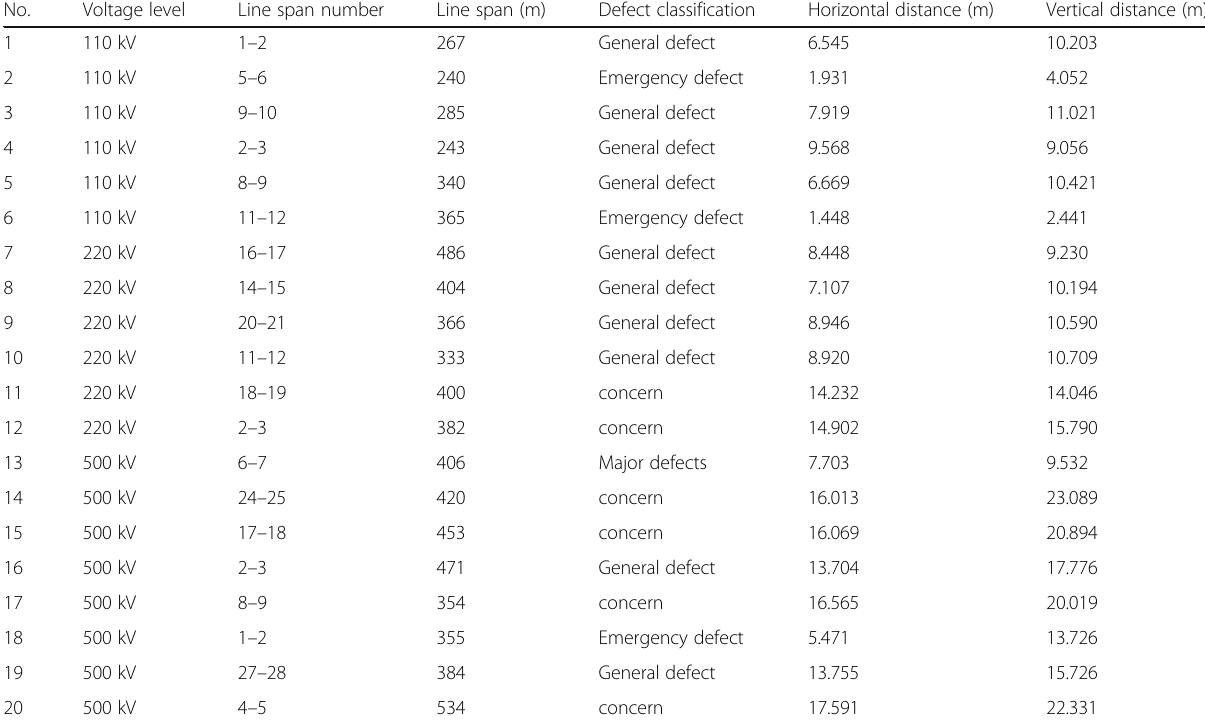
Table 5 Results of tree barrier modeling